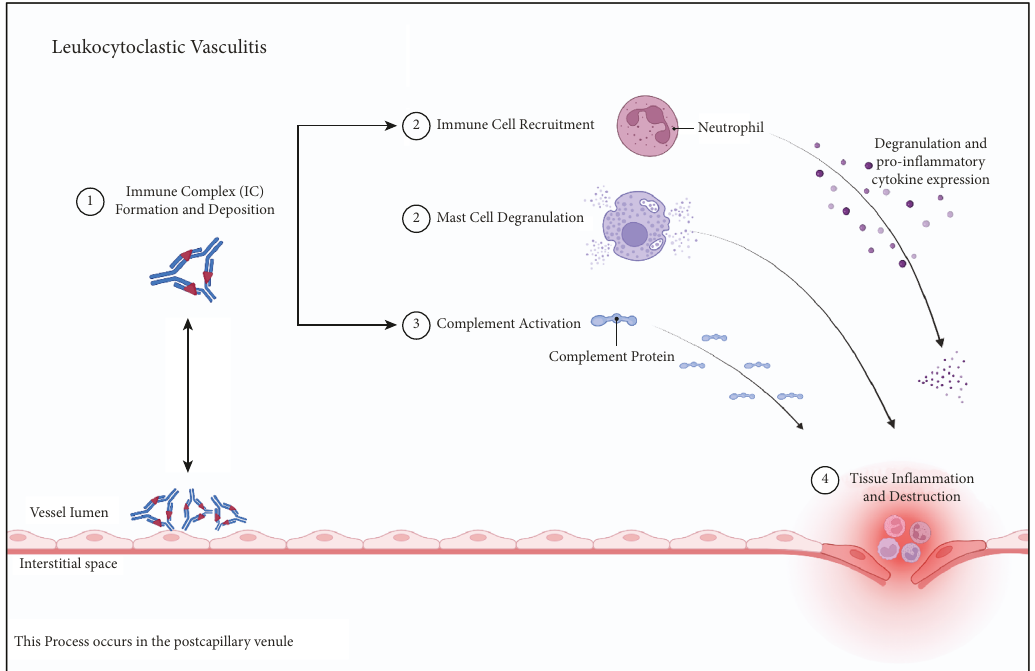
Figure 1: Pathophysiology of leukocytoclastic vasculitis. Immune complexes are deposited within the vessel wall. These complexes activate immune cells, mast cells, and complement proteins. This eventually leads to tissue inflammation and vessel damage. Figure “Created with